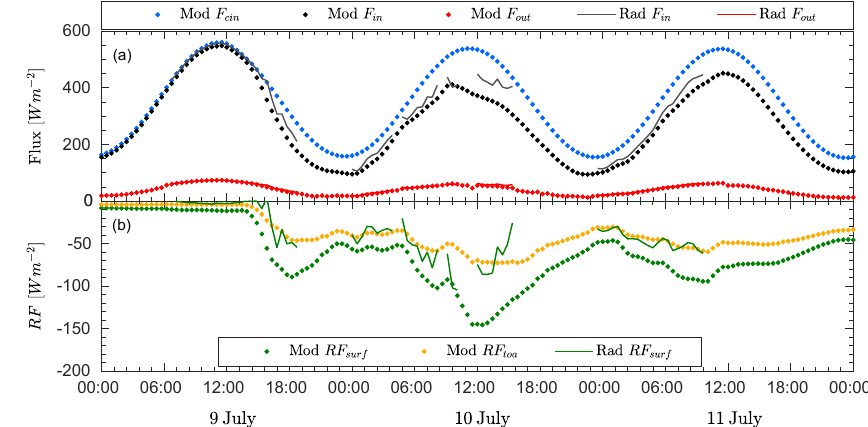
Figure 4. Temporal variability in (a) the surface radiation fluxes: total incoming flux at the polluted case F in (black) and at the clean case F cin (blue), as well as total outgoing flux at the polluted case F out (red), simulated by MODTRAN (dots), and measured by radiometers (lines). The gaps in the radiometer data refer to the cloud contamination. Panel (b) presents radiative forcing at the surface RF surf (green) and at the top of the atmosphere RF toa